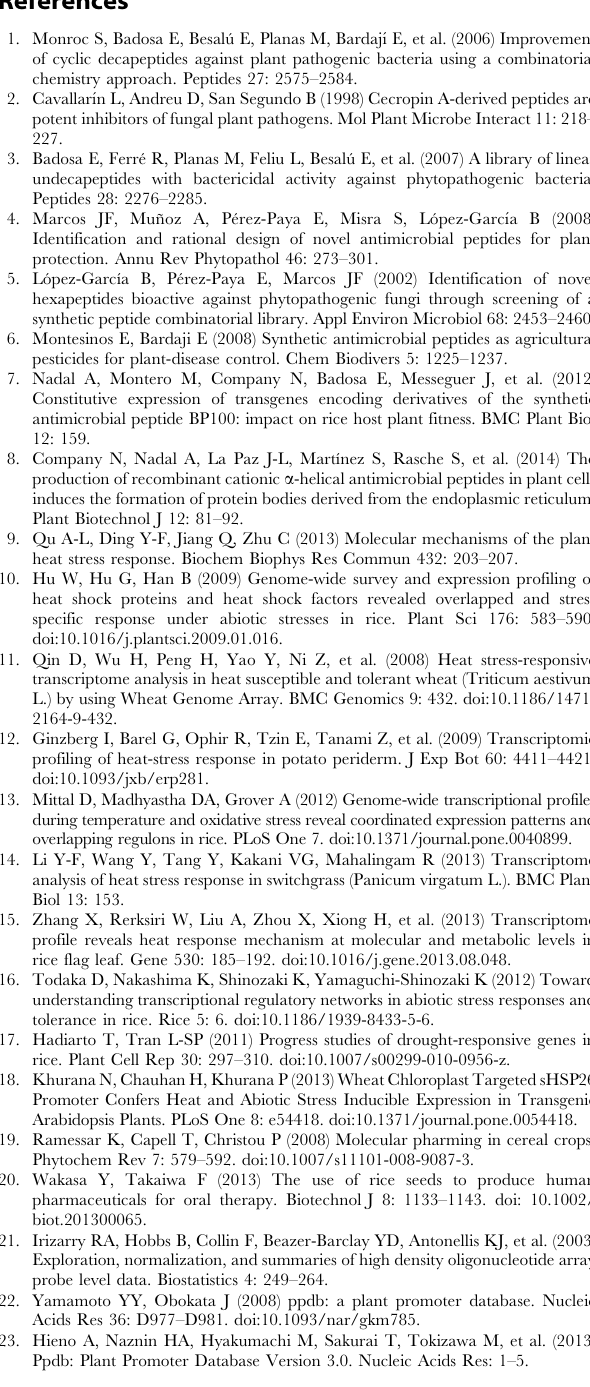
Table S3 Transformation efficiencies of the different constructs encoding the DsRed-tag54 reporter or the phytotoxic BP100.2 AMP, under the control of a rice heat-shock (pHsp18 and pHsp82) or a maize constitutive (pUbi)